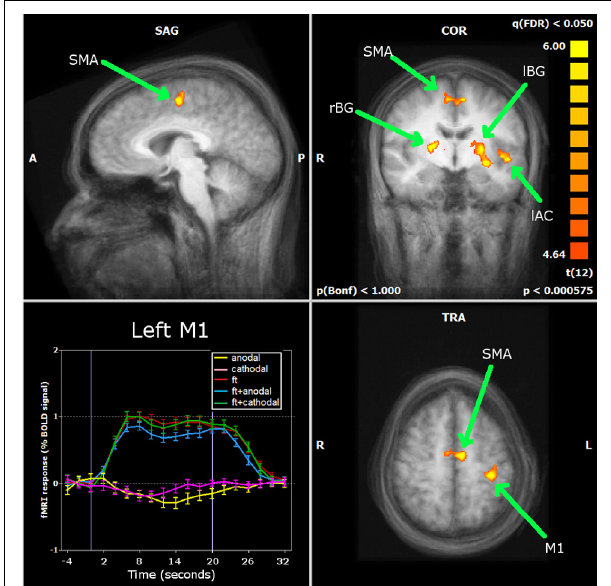
FIGURE 3 | Antal et al. (2011) carried out a ROI analysis on the regions identified by whole brain analysis during finger movements: primary motor cortex (M1), supplementary motor area (SMA), left and right basal ganglia (lBG and rBG) and left auditory cortex (lAC). Neither stimulation alone nor combined with finger movements induced significant changesin the BOLD response of the M1. Only in the SMA was a significant decrease found during anodal stimulation simultaneously with finger movements. Reprinted from Antal et al. (2011), with permission from